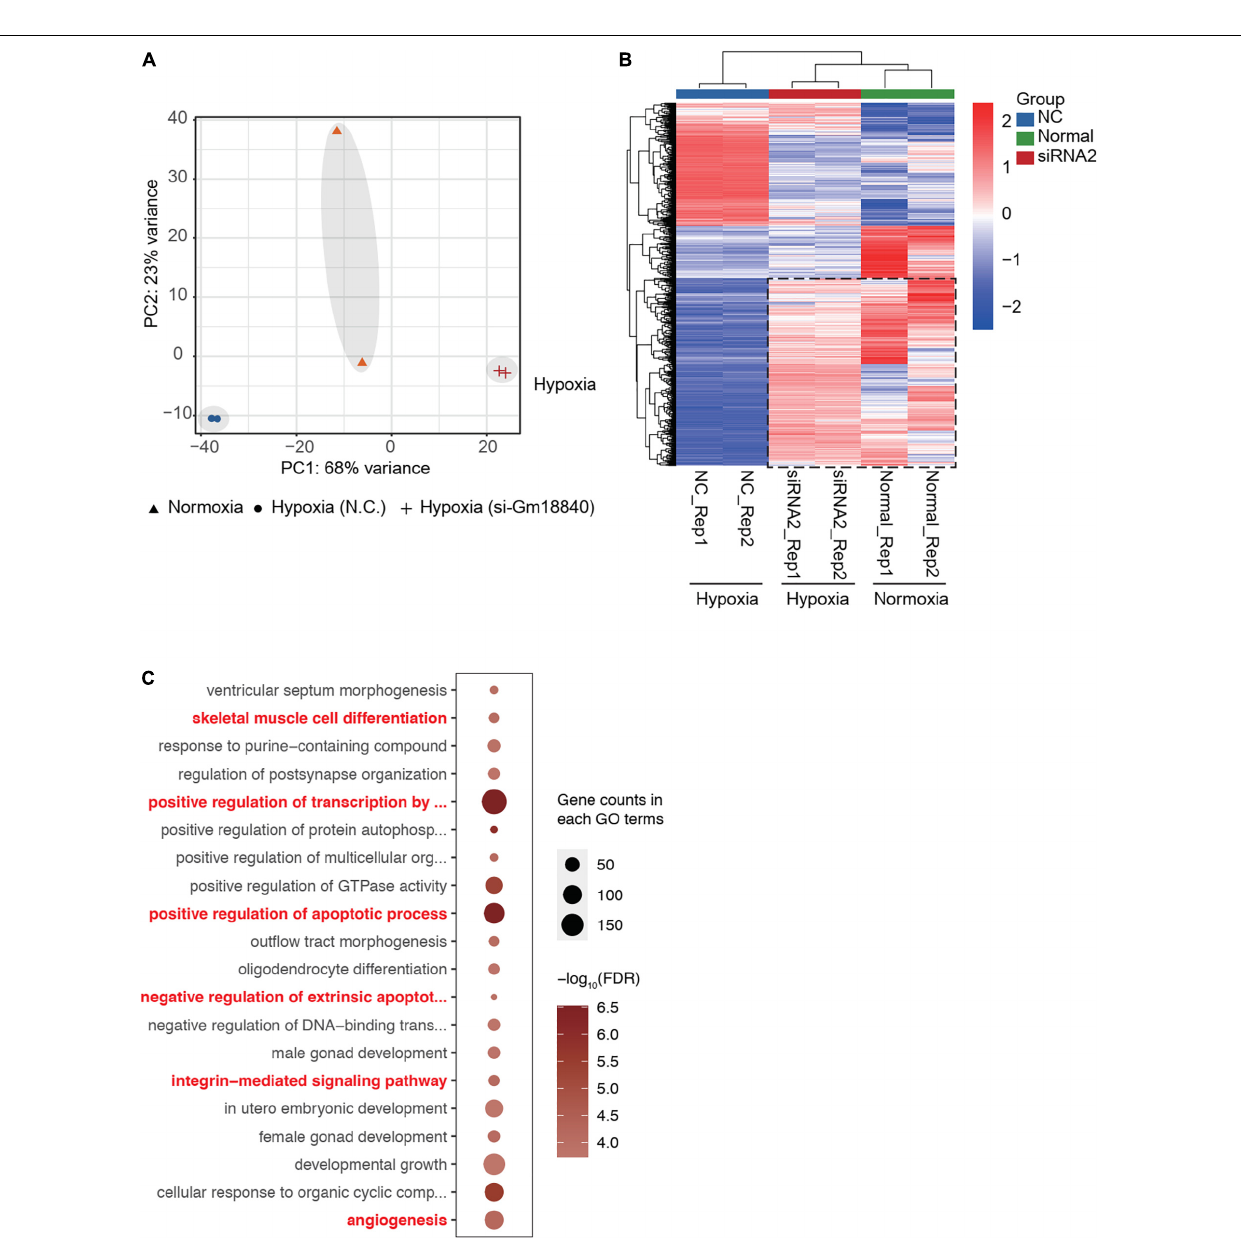
FIGURE 7 | Gm18840 partially restored the transcriptional pattern under hypoxia to that under normoxia. (A) PCA of the transcriptome of HL-1 cells under normoxia and HL-1 cells transfected with negative control siRNA or siRNA targeting Gm18840 under hypoxia. The transcriptomes of HL-1 cells under normoxia and HL-1 cells with Gm18840 knockdown under hypoxia were similar. (B) Knockdown of Gm18840 under hypoxia partially restored gene expression to that under normoxia. Heatmap showing the expression of genes differentially expressed in normoxia (Normal group) compared to hypoxia (NC group). Relative expression of these genes in HL-1 cells under normoxia (Normal group) and HL-1 cells transfected with negative control siRNA or siRNA targeting Gm18840 under hypoxia (SiRNA group) are shown. (C) Gene ontology analysis of genes directly regulated by Gm18840. Genes directly regulated by Gm18840 were defined by ChIRP-seq binding and differentially expressed upon Gm18840